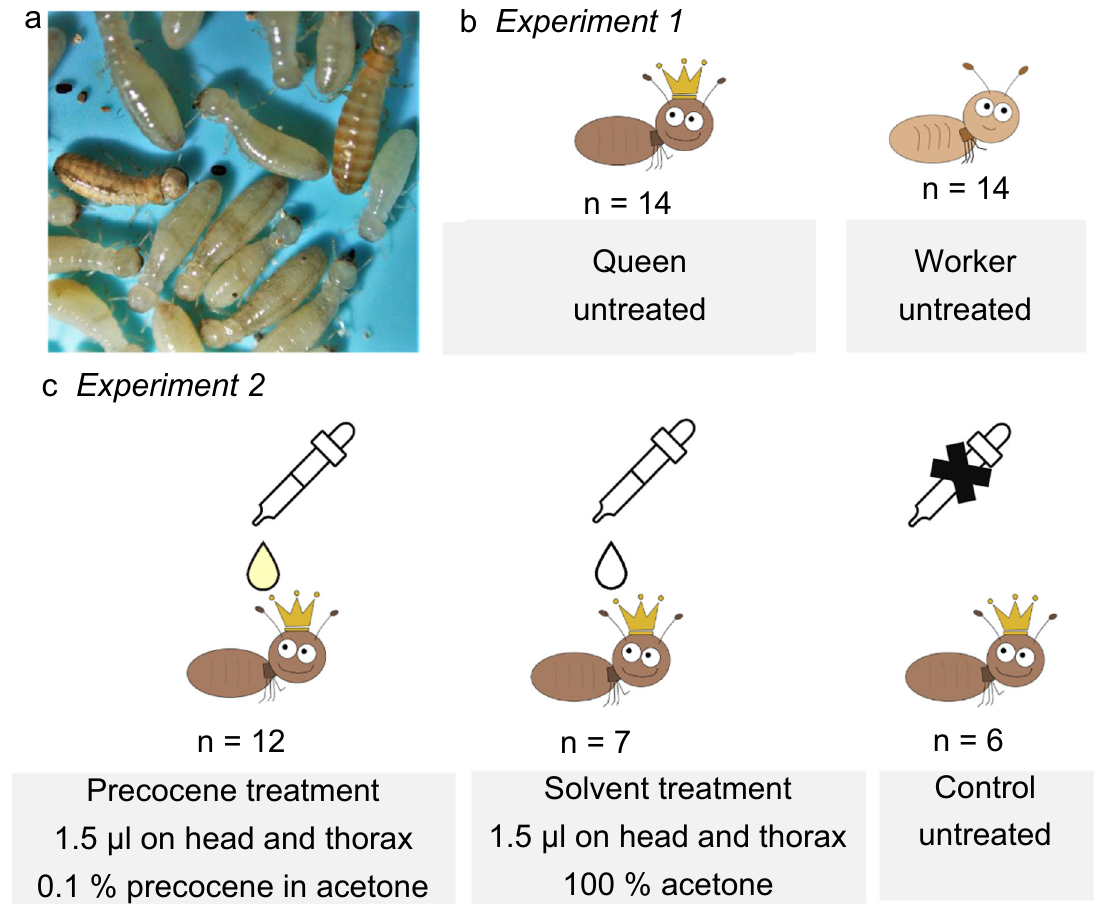
Fig. 2 Experimental setup. a Insight into a Cryptotermes secundus colony with neotenic queen and king (darker) and workers (paler). b Experiment 1: the Queen network experiment compared gene expression between queens versus workers. It included 14 untreated queens and 14 untreated workers. c Experiment 2: the JH-manipulation experiment compared gene expression between precocene-treated, solvent-treated, and untreated queens. For the latter, we pharmacologically reduced JH in twelve queens by topical application of 1.5 µ l of 0.1% precocene in acetone on head and thorax ( “ precocene treatment ” ). To control for solvent-induced effects, we topically applied 1.5 µ l of pure acetone to seven queens ( “ solvent treatment ” ). As a treatment control we used six completely untreated queens ( “ control ”